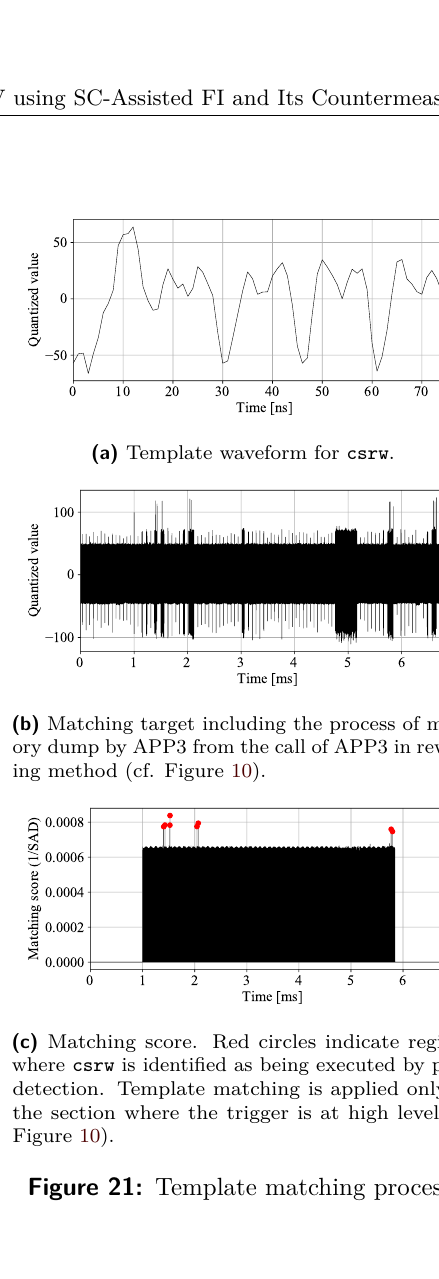
Figure 20: Side-channel template creation process.